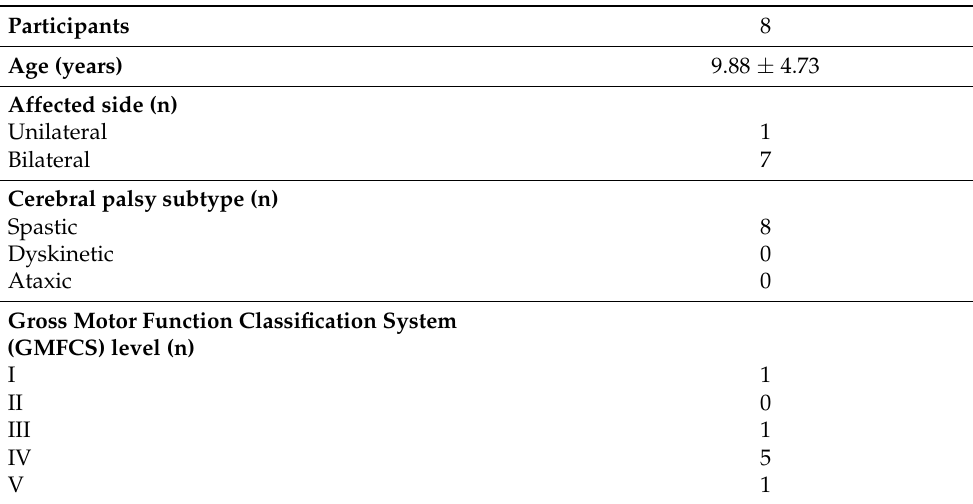
Table 1. Participants’ characteristics. Notably, the age is expressed as mean ± standard deviation; whereas the qualitative parameters are expressed as absolute